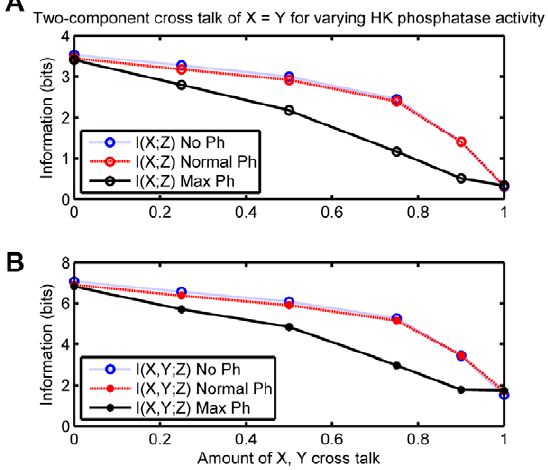
Fig. 7. As shown in Fig. 7 the phosphatase activity of the HK has